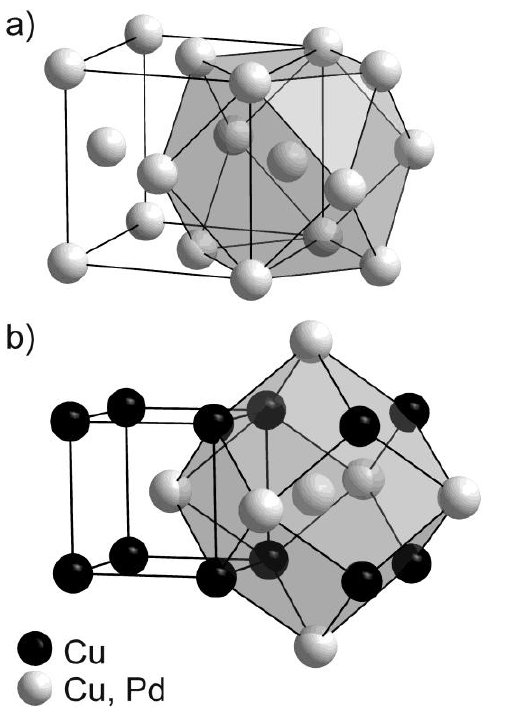
Figure 1. Crystal structure representation highlighting the different coordination polyhedra of ( a ) disordered Cu Pd (Cu-type, Fm3m , a = 3.739(1) Å); and ( b ) partly 60 40